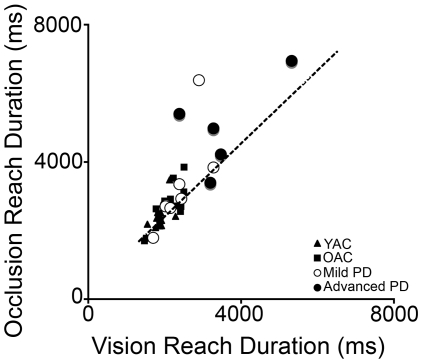
Correlation between total reach duration with vision and total reach duration with occlusion.The line represents the regression of the control groups. Note the disproportionate increase in duration for some PD subjects.